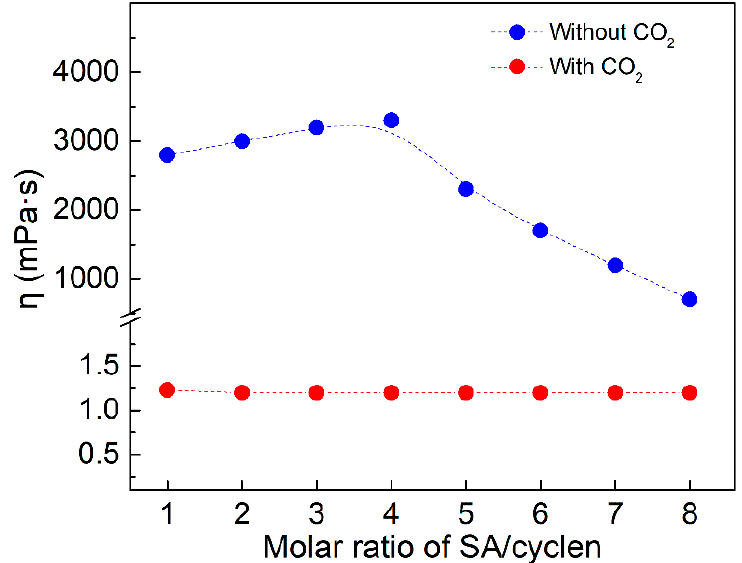
Figure 5. Change in viscosity with varying molar ratio of CSDS/CTMPDA with SA concentration fixed at 1200 mM. (Temperature, 25 °C; shear rate, 10 s − 1 ).